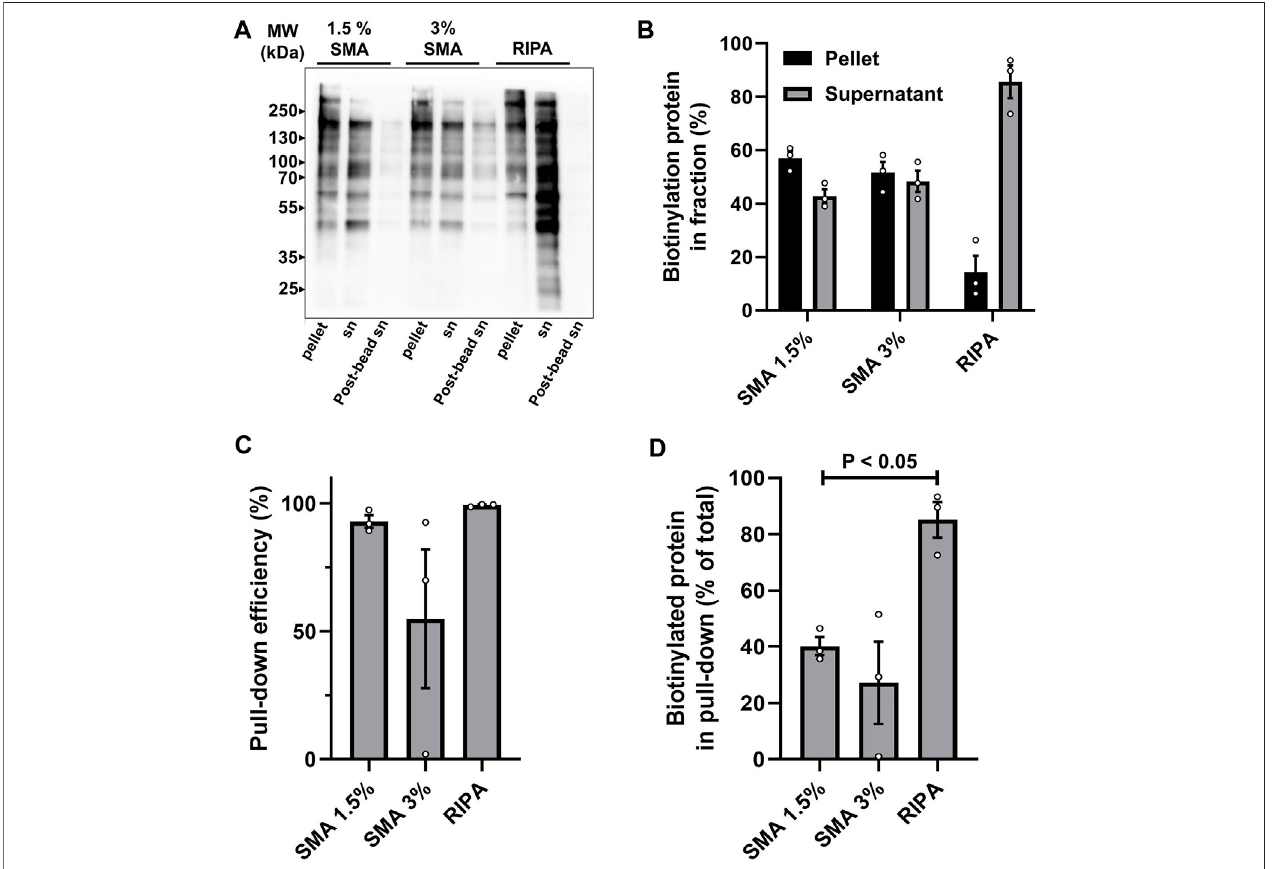
FIGURE2| Analysisofsolubilizationandpull-downef fi ciencyofsurfacebiotinylatedproteins.Cellswerelabeledwithsulfo-NHS-SS-biotinandextractedwitheither 1.5% SMA, 3% SMA, or RIPA buffer. Extracts were ultracentrifuged and aliquots of pellet and supernatant (sn) fractions separated by non-reducing SDS-PAGE and transferredtonitrocellulose.NeutrAvidinpull-downwasperformedonsupernatantsandunboundmaterial(post-beadsn)wasseparatedonsamegels. (A) Streptavidin- HRPdetectionofbiotinylatedproteinsinpellet,supernatant,andpost-beadsupernatantsfromeachoftheextractionconditions.Arepresentativeblotisshown. (B) Quanti fi cationofsolubilizationef fi ciency.Theamountofbiotinylatedproteininpelletsandsupernatantswasmeasuredbydensitometryoftheentirelane.Thepercentage of the total biotinylated protein (i.e., combined sn + pellet) in sn and pellet for each of the extraction conditions was calculated. Quanti fi cation from three independent experimentsisshown(valuesaremean ± SD). (C) Quanti fi cationofpull-downef fi ciencyfromsupernatants.Pull-downef fi ciencywasdetermined bydensitometry values of pre-bead and post-bead supernatants for each of the extraction conditions. The assumption was made that the biotinylated proteins not in the post-bead supernatants were bead associated. Quanti fi cation from three independent experiments is shown (values are mean ± SD). (D) Quanti fi cation of recovery of biotinylated protein on beads. Calculated by combining the solubilization ef fi ciency and pull-down ef fi ciency. Biotinylated protein associated with beads is expressed as percentage of total biotinylated protein in sample (i.e., combined sn + pellet) for each of the extraction conditions. Quanti fi cation from three independent experiments shows a signi fi cant difference p < 0.05 (indicated by bar) between the amount of biotinylated protein recovered following 1.5% SMA and RIPA extraction (values are mean ± SD, two-tailed t -test, p -value (cid:2) 0.016). Original blots used for quanti fi cation are presented in Supplementary Figure S1